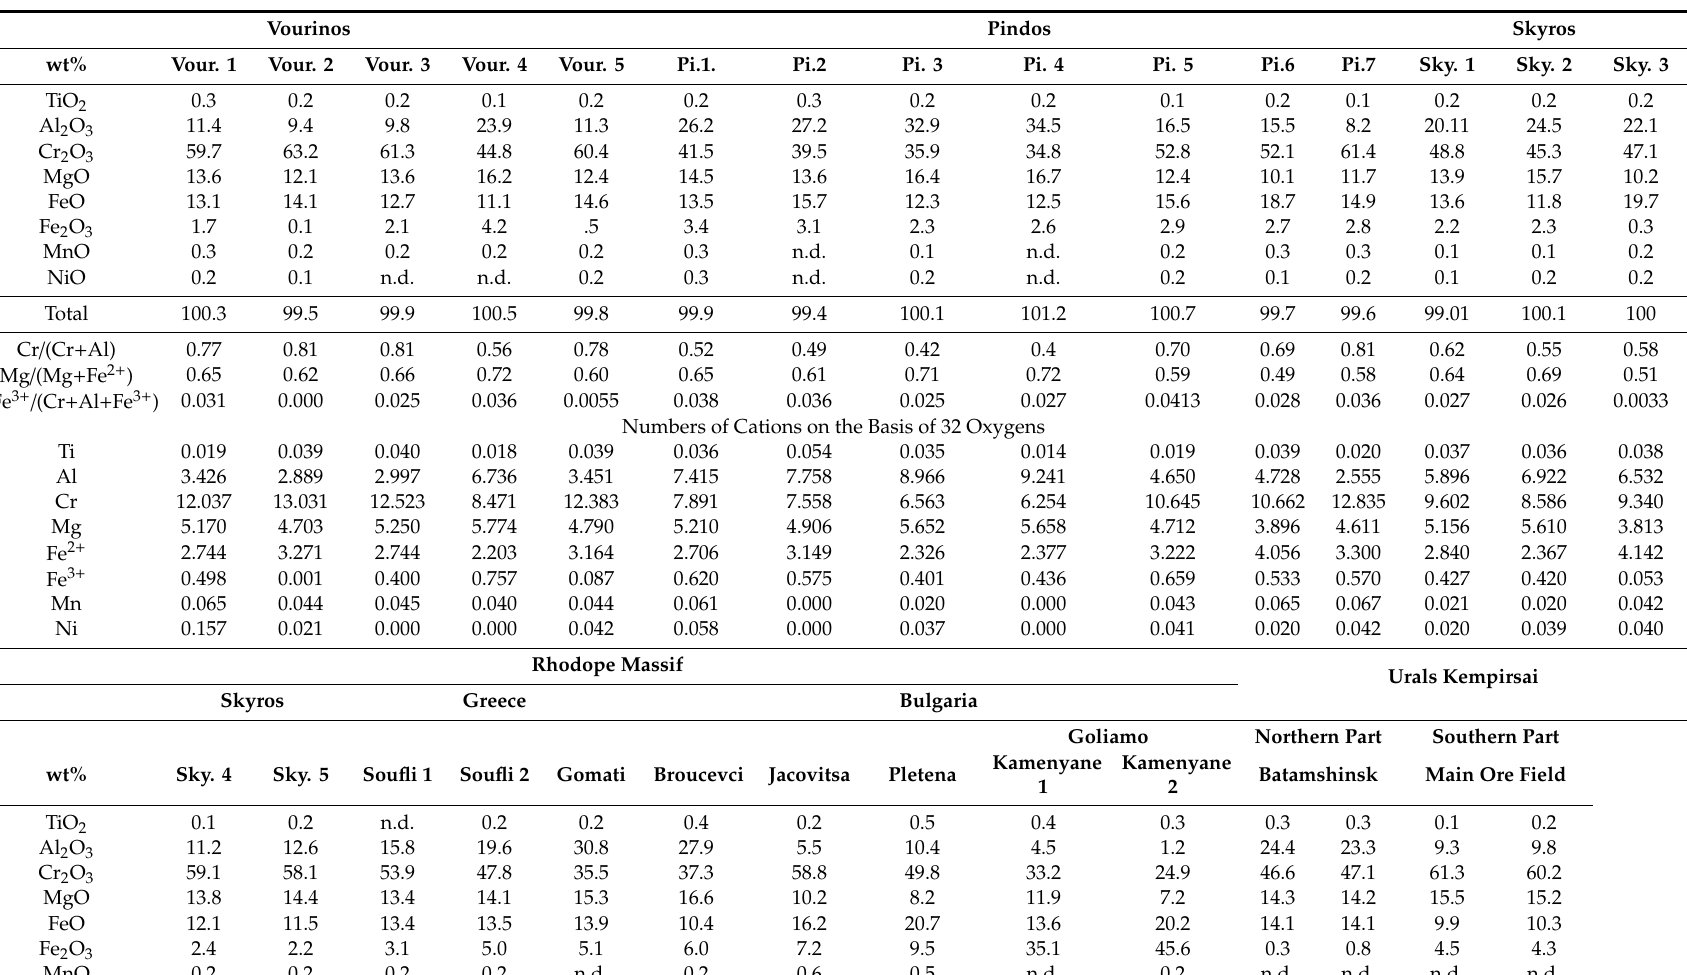
Table 1. Electron scanning electron microscope (SEM) / energy-dispersive spectroscopy (EDS) analyses of chromite from chromitites of Greece, Bulgaria and Kempirsai (Urals). Vourinos Pindos Skyros wt% Vour. 1 Vour. 2 Vour. 3 Vour. 4